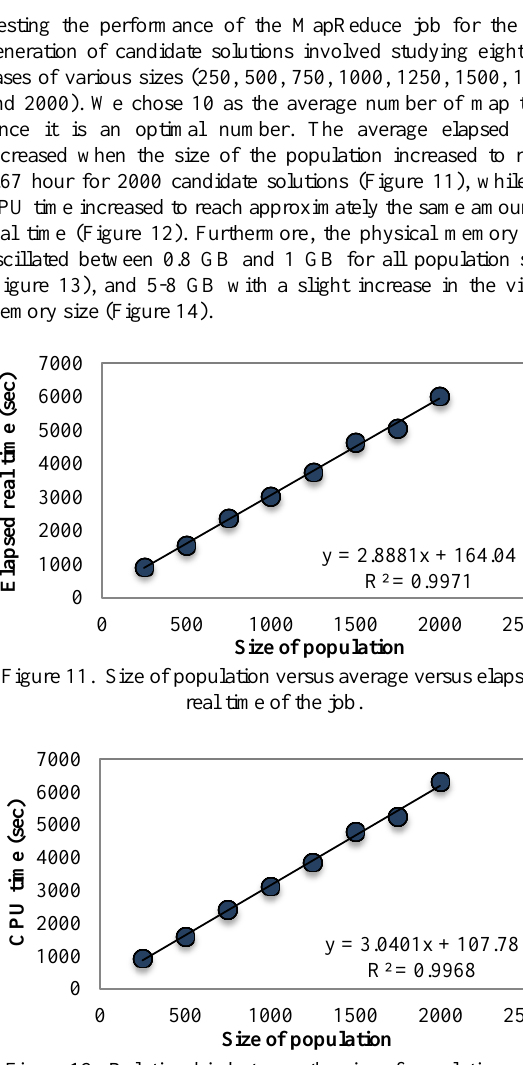
Figure 12. Relationship between the size of population and average CPU time of the job.